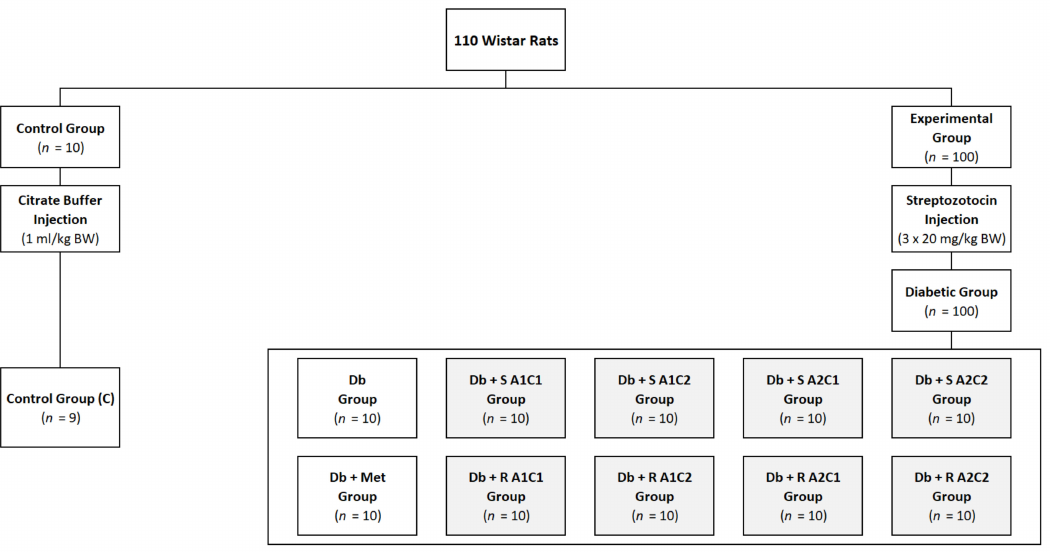
Figure 4. The allocation of rats to individual groups. Control group (C): healthy rats receiving AIN-93M diet; Db group: diabetic rats receiving HFD; Db + Met group: diabetic rats receiving HFD with 0.3% metformin; Db + S A1C1 group: diabetic rats receiving HFD with 2.5% ST, 2% L-arg and 0.001% Cr; Db + S A1C2 group: diabetic rats receiving HFD with 2.5% ST, 2% L-arg and 0.005% Cr; Db + S A2C1 group: diabetic rats receiving HFD with 2.5% ST, 4% L-arg and 0.001% Cr; Db + S A2C2 group: diabetic rats receiving HFD with 2.5% ST, 4% L-arg and 0.005% Cr; Db + RA1C1 group: diabetic rats receiving HFD with 2.5% RA, 2% L-arg and 0.001% Cr; Db + RA1C2 group: diabetic rats receiving HFD with 2.5% RA, 2% L-arg and 0.005% Cr; Db + RA2C1 group: diabetic rats receiving HFD with 2.5% RA, 4% L-arg and 0.001% Cr; Db + RA2C2 group: diabetic rats receiving HFD with 2.5% RA, 4% L-arg and 0.005%